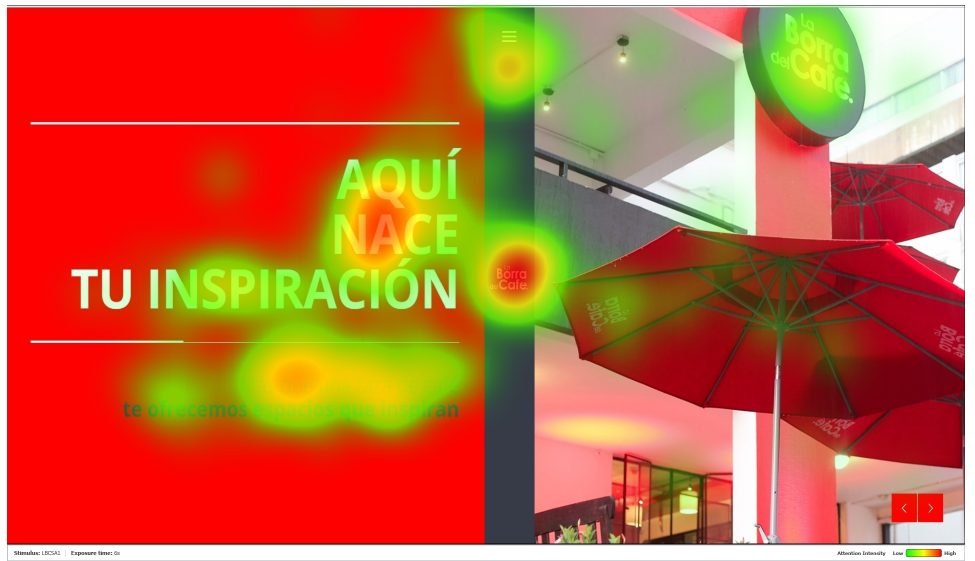
Figure 5. Old website design: heat